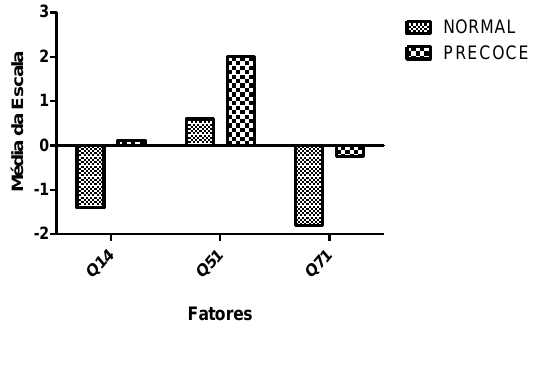
Figura 1. Direcionalidade e intensidade dos fatores geradores de